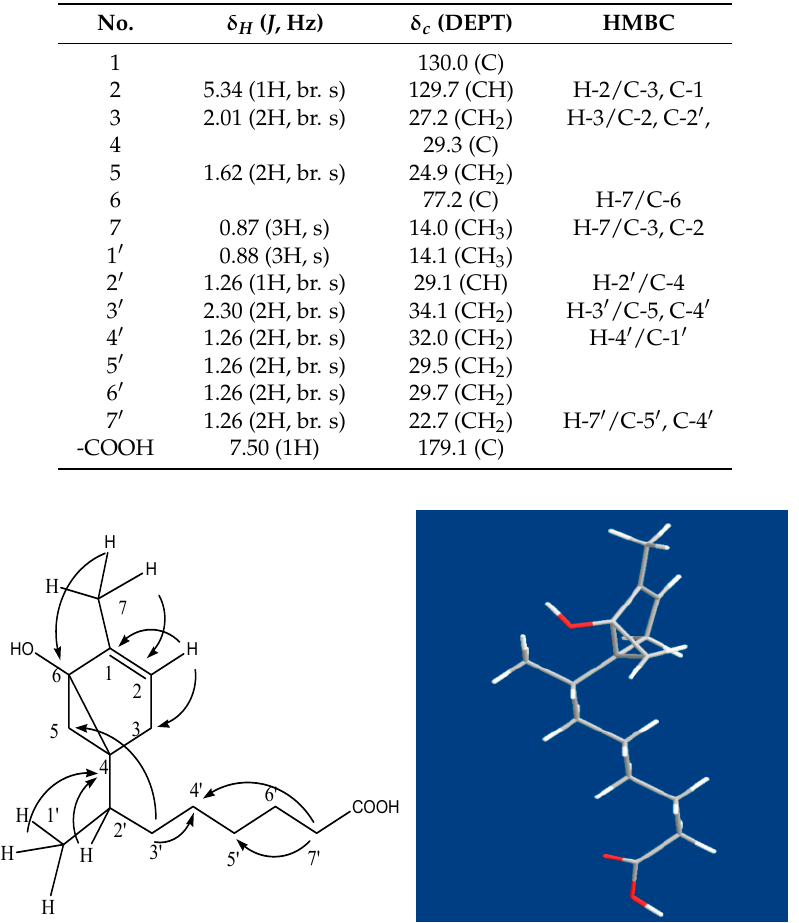
Table 2. 1 H-NMR (400 MHz) and 13 C-NMR (100 MHz) data of compound 3 (in CDCl 3 ).